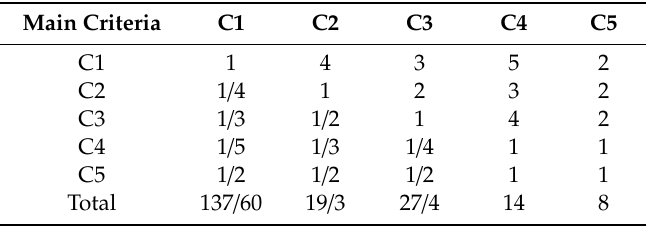
Table 5. The comparison matrix between the main criteria.